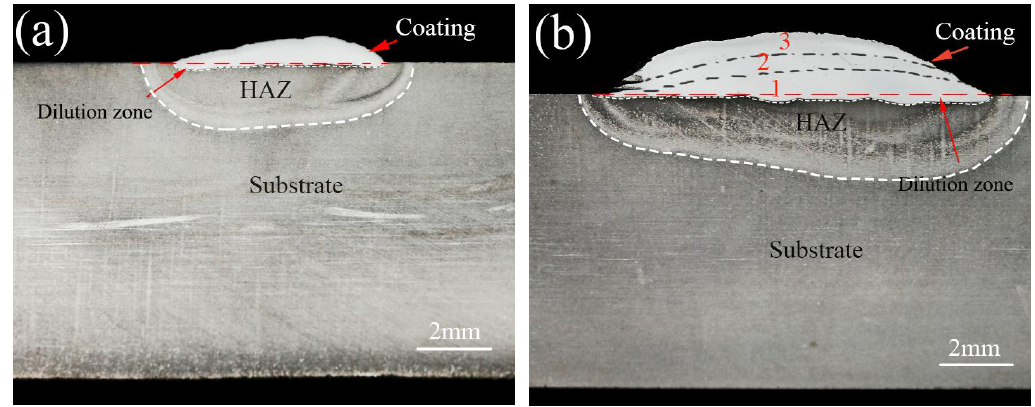
Figure 2. The profiles of cladded coatings with different layers ( a ) monolayer and ( b )